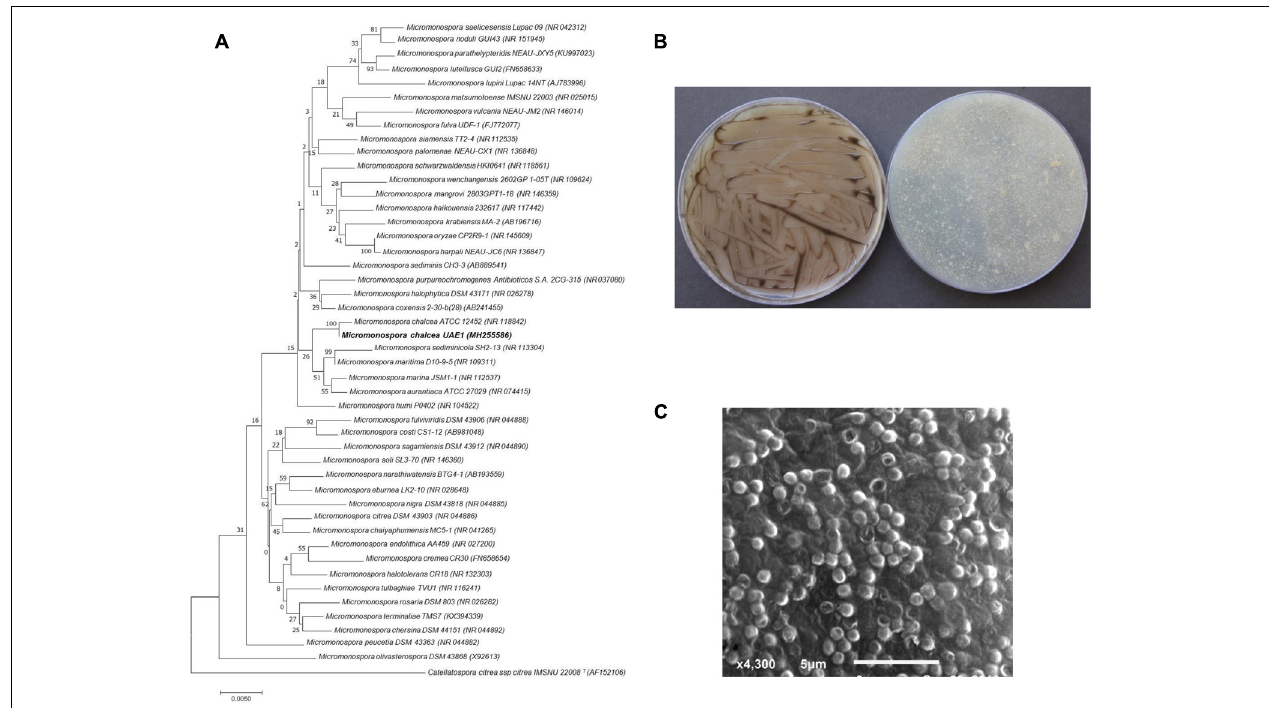
FIGURE 1 | Taxonomic determination of Micromonospora chalcea UAE1, based on phylogenetic, cultural, and morphological characteristics. (A) The tree showing the phylogenetic relationships between M. chalcea UAE1 ( MH255586 ; 1,480 bp) and other members of Micromonospora spp. on the basis of 16 S rRNA sequences. (B) substrate mycelia without the formation of aerial mycelium (left) and the color of the substrate mycelia (right) growing on ISP medium 3 supplemented with yeast extract, and (C) scanning electron micrograph (4,000X) of the single oval to spherical smooth-surfaced spores of the strain of M. chalcea UAE1. In (A) numbers at nodes indicate percentage levels of bootstrap support based on a maximum likelihood analysis of 1,000 resampled datasets. Bar, 0.005 substitutions per site. Catellatospora citrea spp. citrea IMSNU 22008 (AF152106) was used as an outgroup. GenBank accession numbers are given in parentheses.